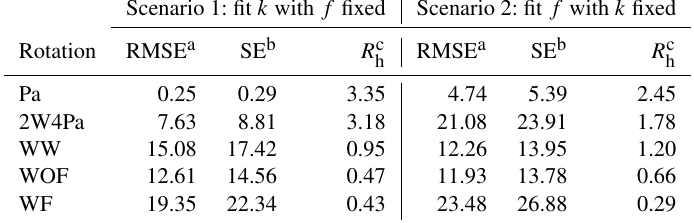
Table 4. Turnover model goodness-of-fit statistics. Scenario 1: fit k with f fixed Scenario 2: fit f with k